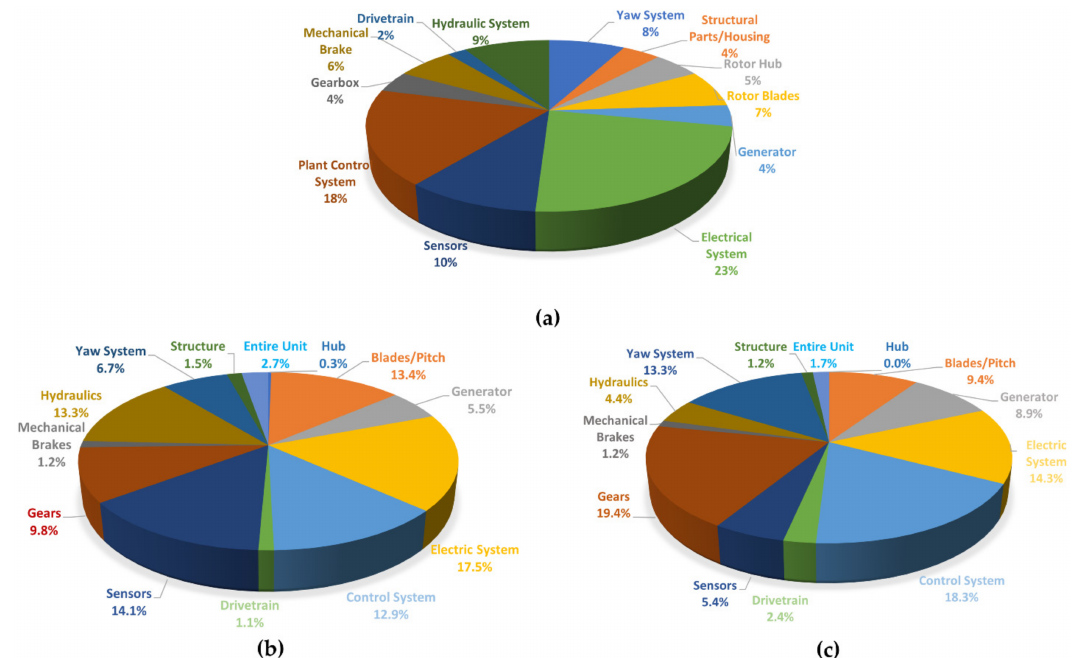
Figure 7. Damage and failure statistics. ( a ) Percentage of unforeseen malfunctions as recorded in Germany for 1500 wind turbines. Based on data retrieved from Ref. [42], collected over 15 years (34,582 events). ( b , c ) percentage distribution of the total number of failures and downtime for WTs. Based on data retrieved from Ref. [43], collected from several sources in Sweden, totalling about 600 WTs from 2000 to 2004 (1202 events, 156,202 h). The nomenclature used in the original sources is reproduced for all